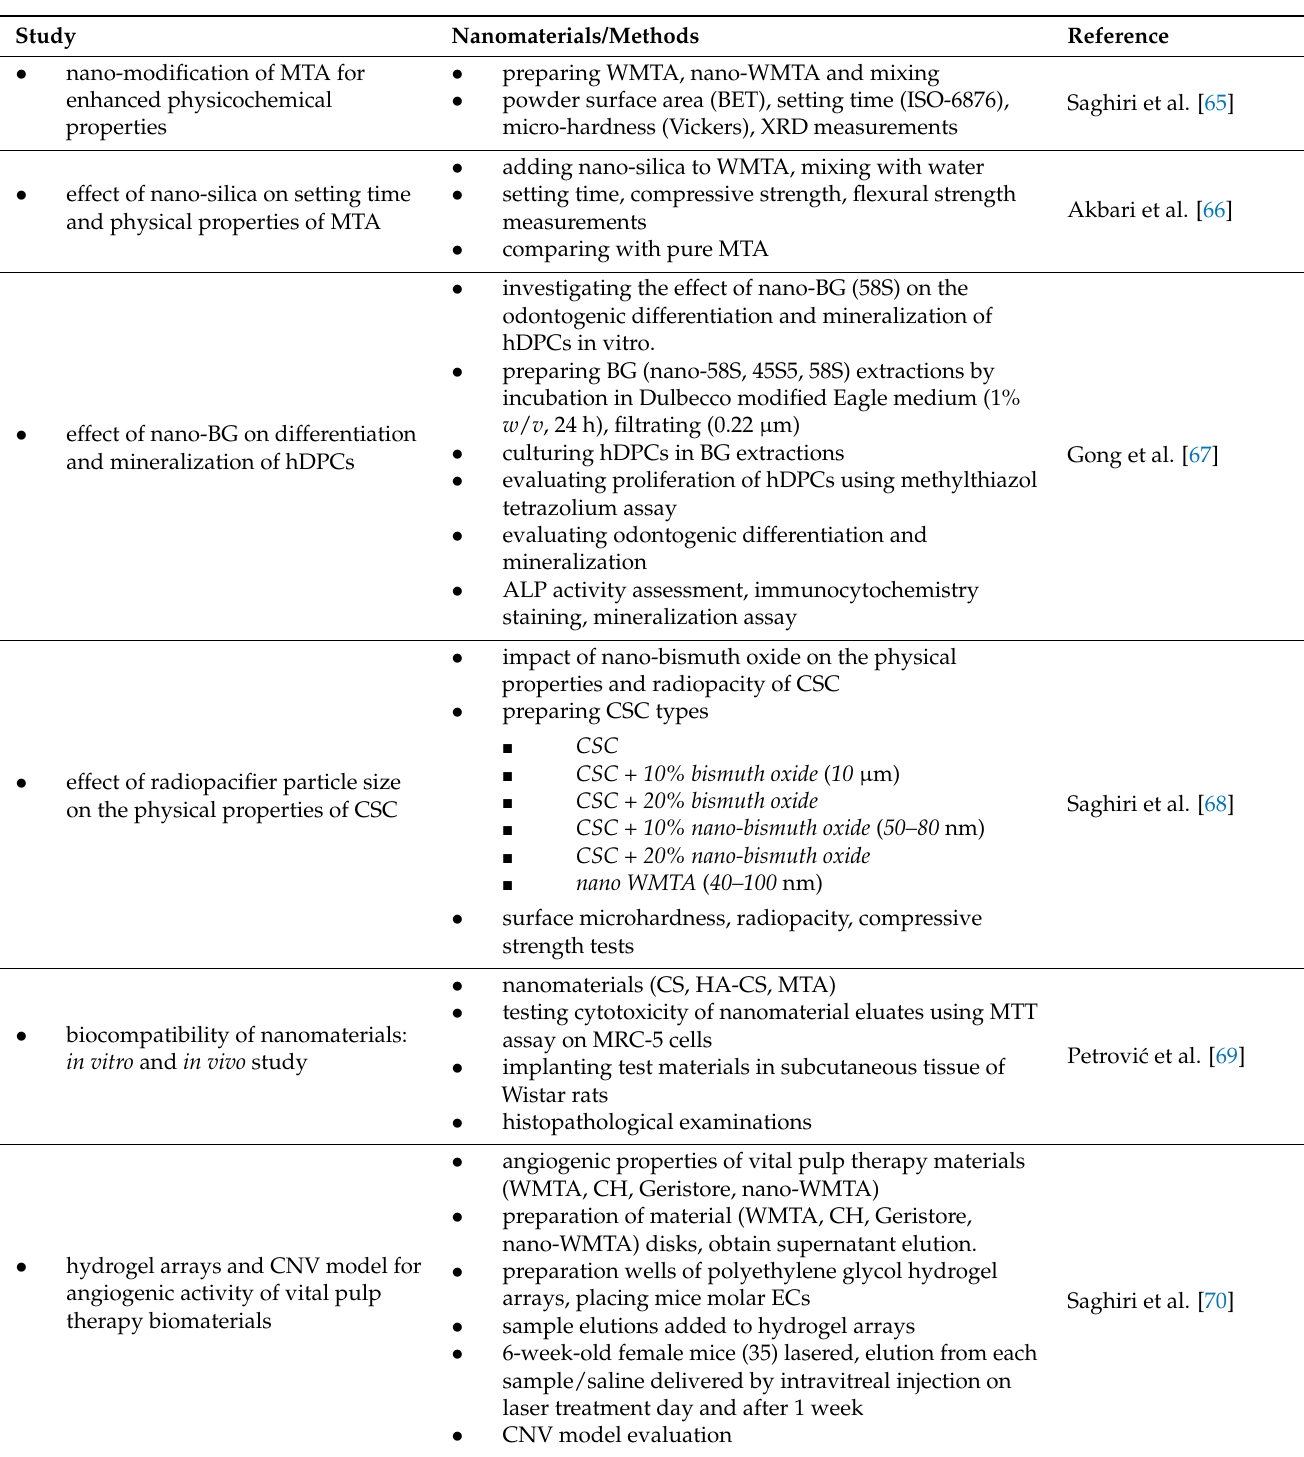
Table 1. Nanotechnology applications in endodontics: nano-improvement of materials.